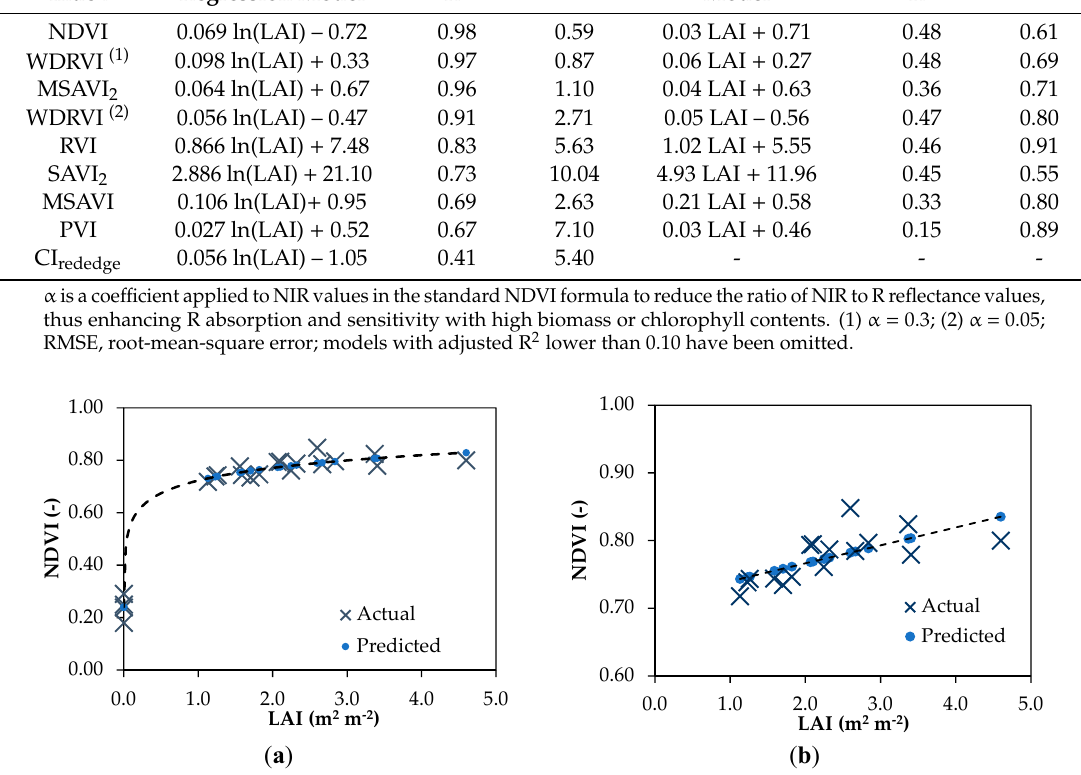
Figure 5. Regression of NDVI as a function of LAI: ( a ) Logarithmic; and, ( b ) linear.